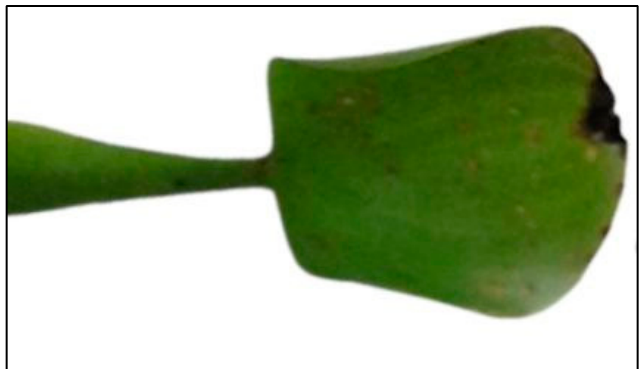
Figure 11. Eichhornia crassipes leaf presenting necrosis on margin and apex due to the exposure to 15 mg L − 1 of fluoride for 10 days.